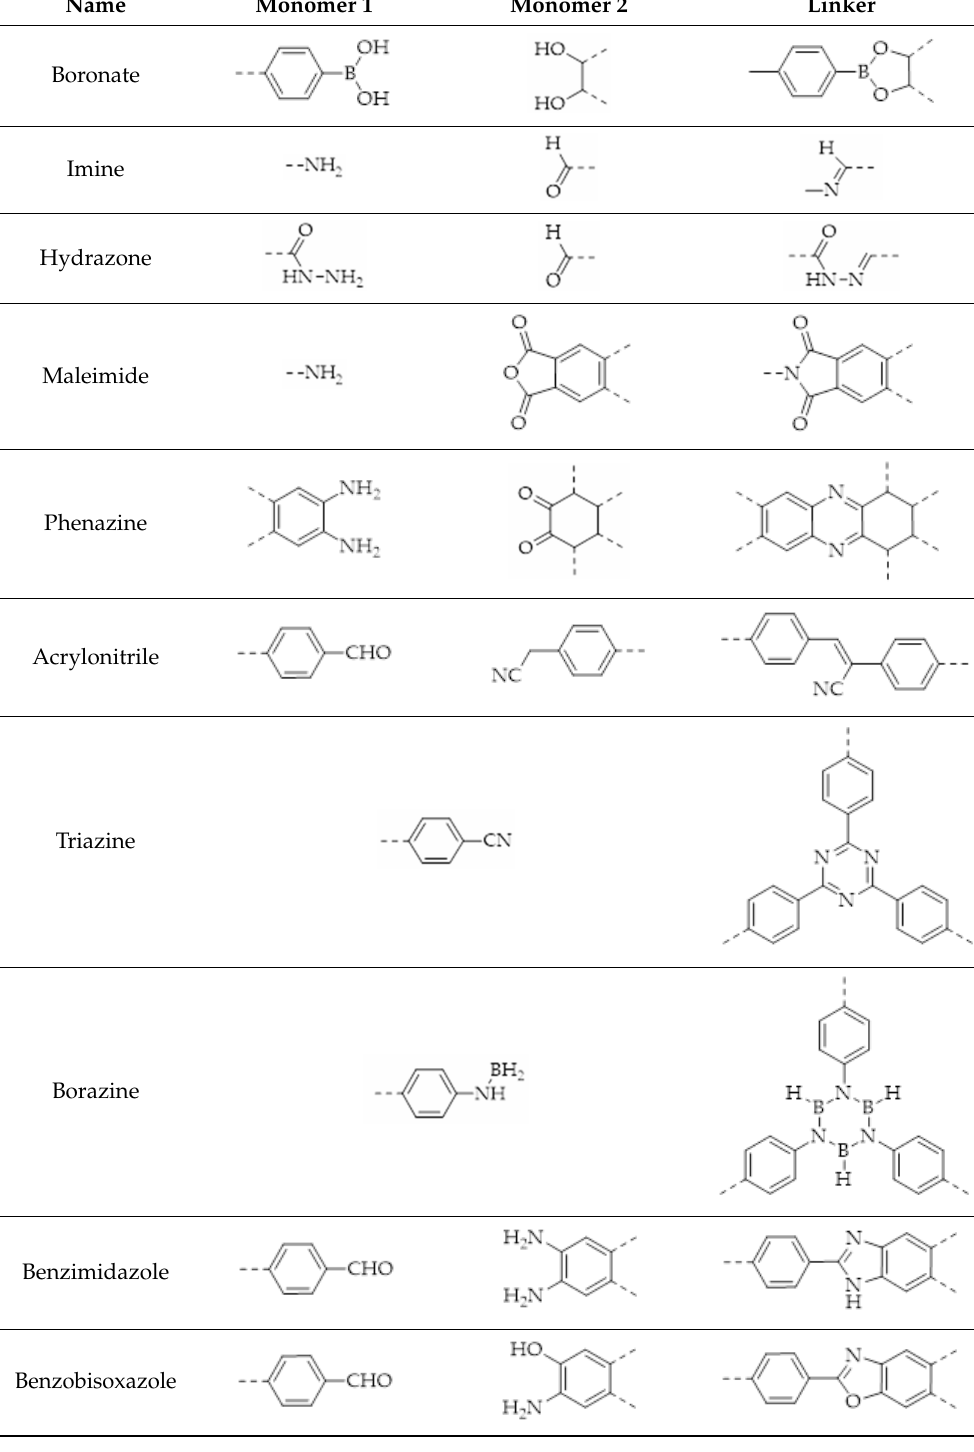
Figure 1. The basic topology of the COFs. Table 1. The dynamic linkages for COF synthesis.